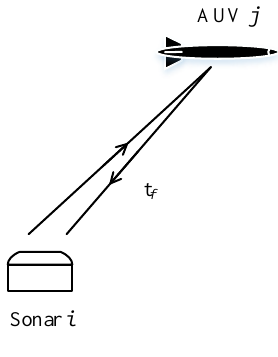
Figure 3. Schematic diagram of the relative distance